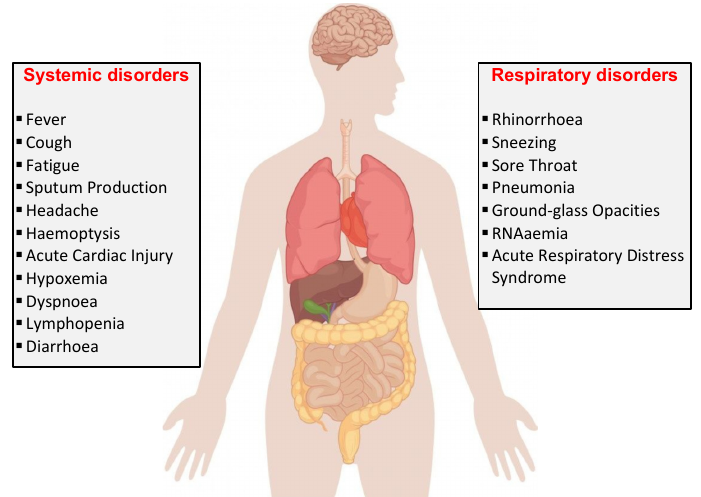
Figure 3. COVID-19 effects on the human body.